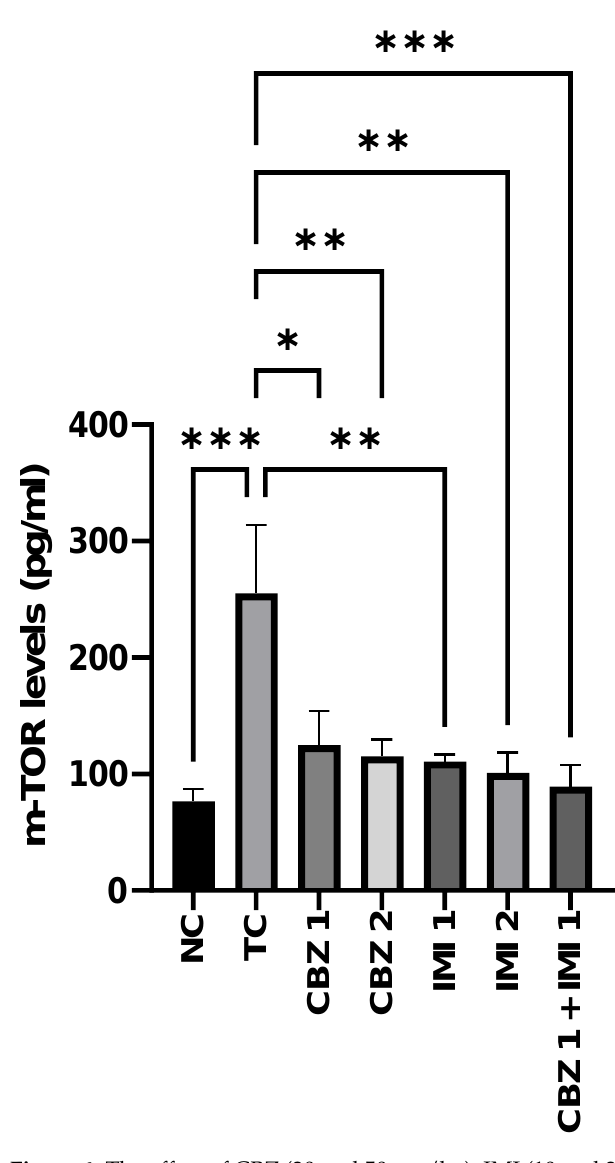
Figure 6. The effect of CBZ (20 and 50 mg/kg), IMI (10 and 20 mg/kg) and CBZ (20 mg/kg) + IMI (10 mg/kg) on hippocampal mTOR levels. Statistical significance between means from toxic control and other groups was correlated by applying one-way ANOVA followed by post hoc Dunnet’s test. ( p < 0.05 *, p < 0.01 **, p < 0.001 *** significance levels). CBZ, IMI, and TC indicate carbamazepine, imipramine, and toxic control, respectively.